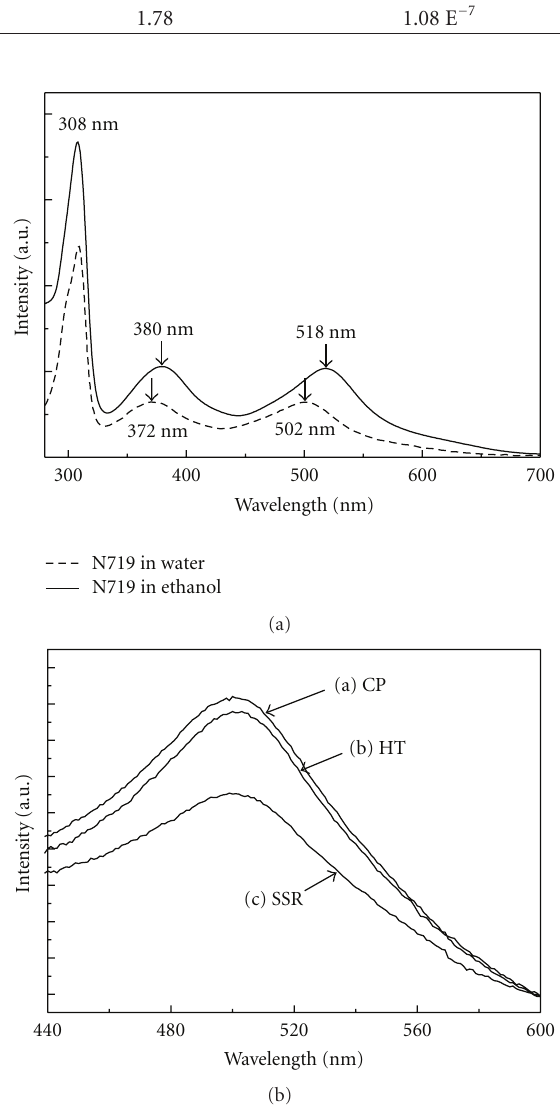
Figure 5: (a) Absorption spectra of N719 in di ff erent solvents. (b) UV-vis absorption spectra of NaOH aqueous solution containing the desorbed dye from the surface of the three BaSnO 3 films: CP (curve a), HT (curve b), and SSR (curve